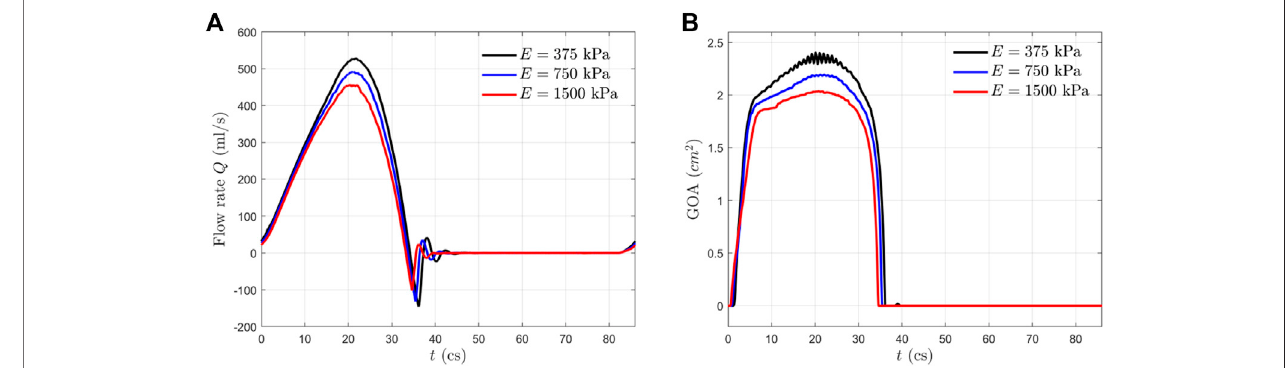
FIGURE 4 | (A) Transient fl ow rate Q and (B) GOA for the three FSI cases.